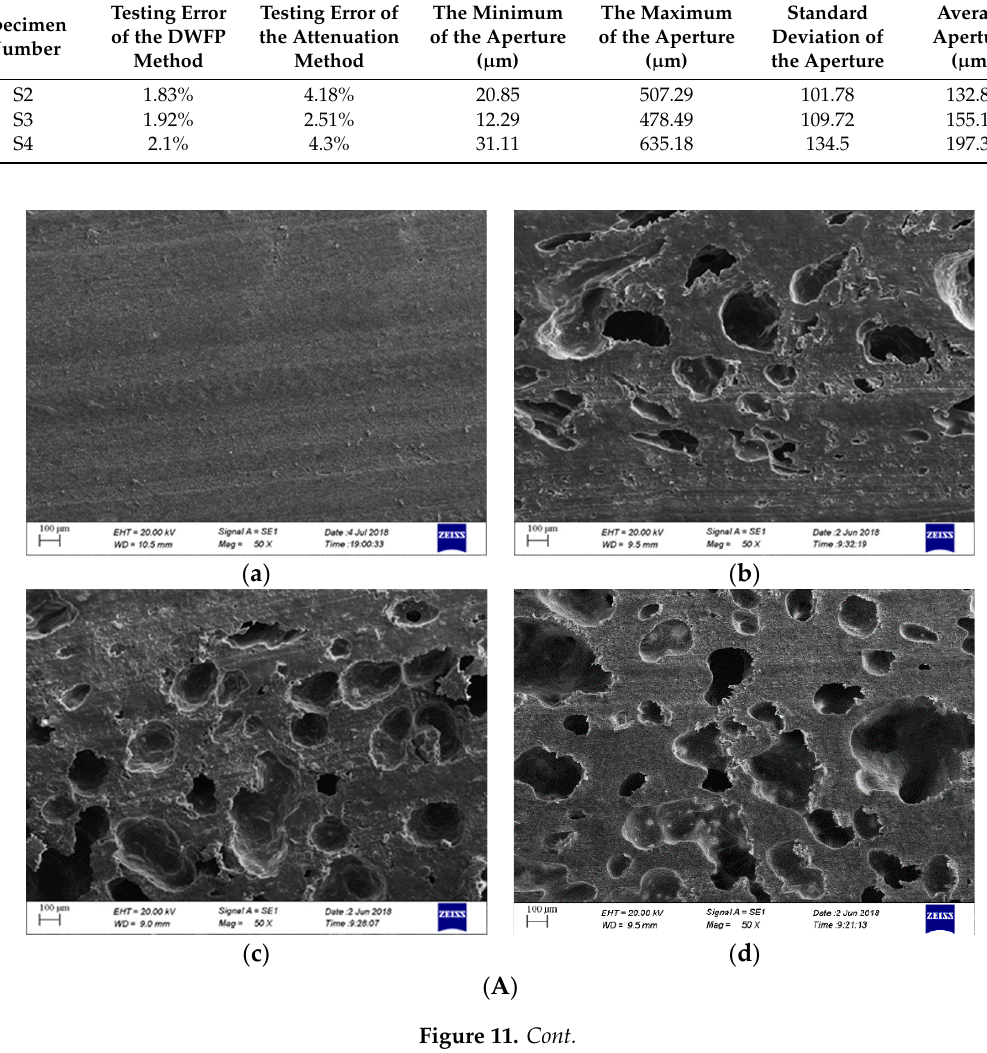
Table 1. The statistical results of parameters.